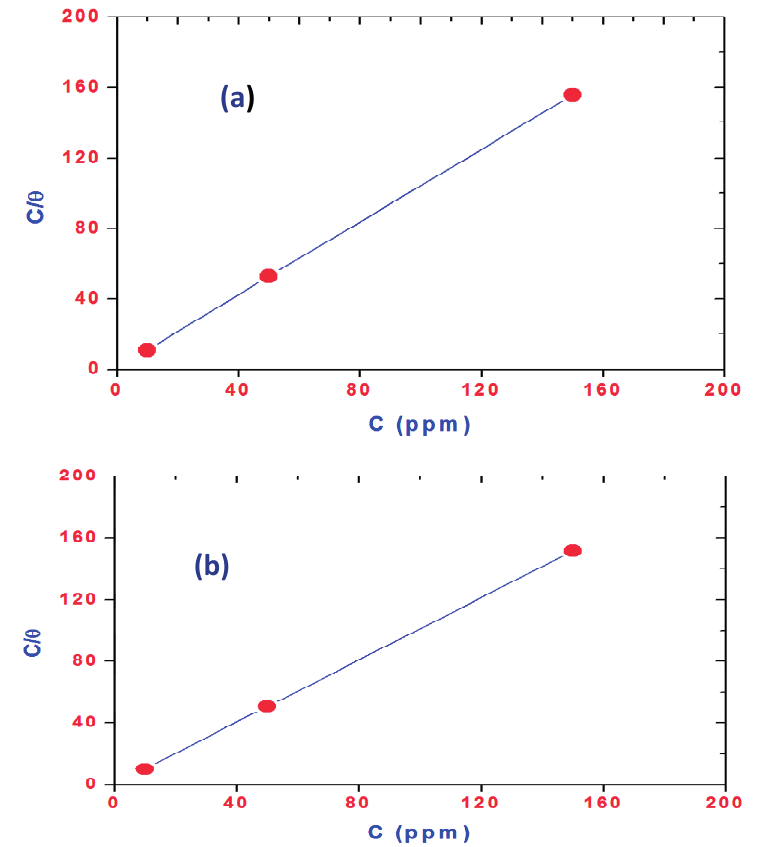
Figure 15. Langmuir adsorption plot of steel in 1 M HCl solution containing different concentrations of ( a ) OA-TS and ( b )